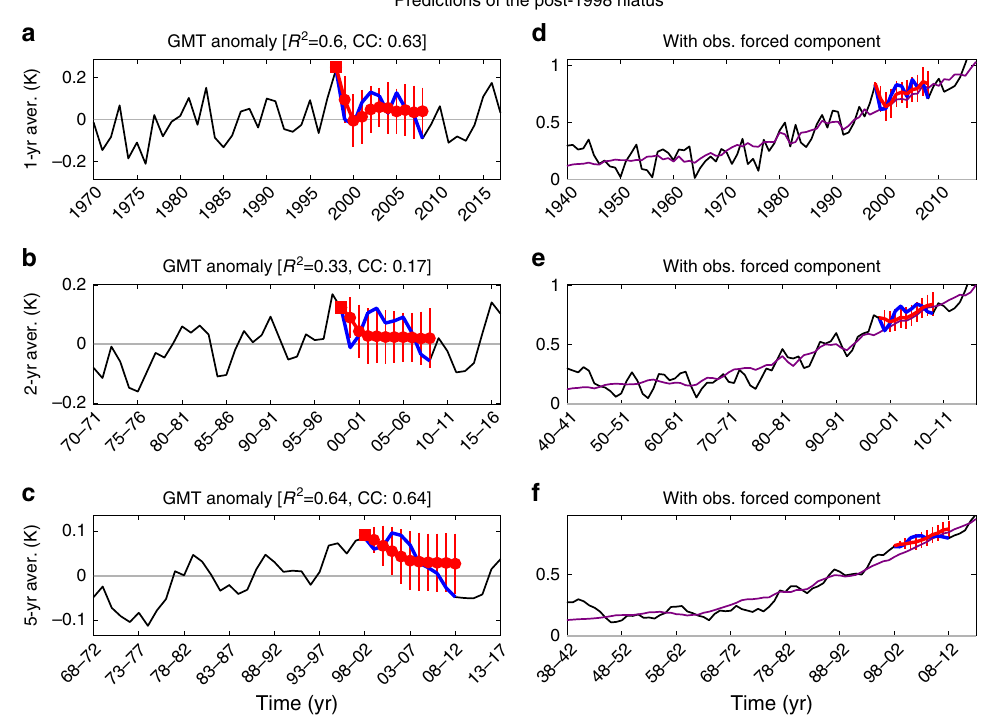
Fig. 6 Predictions of the post-1998 hiatus observed through GMT anomalies. Observation and prediction of GMT anomalies averaged over a 1 year, b 2 years, and c 5 years. Hiatus is de fi ned as the post-1998 decade (blue line) showing a decrease of GMT anomalies partially or totally offsetting the forced trend. Decadal prediction means and standard deviations (red circles and vertical lines, respectively) are obtained using PROCAST initialized in 1998 (red squares). Prediction skills are computed through the coef fi cient of determination ( R 2 ) and the correlation coef fi cient (CC) over the post-1998 decade. d – f are equivalent to a – c with the addition of the observed component attributed to forcing (purple